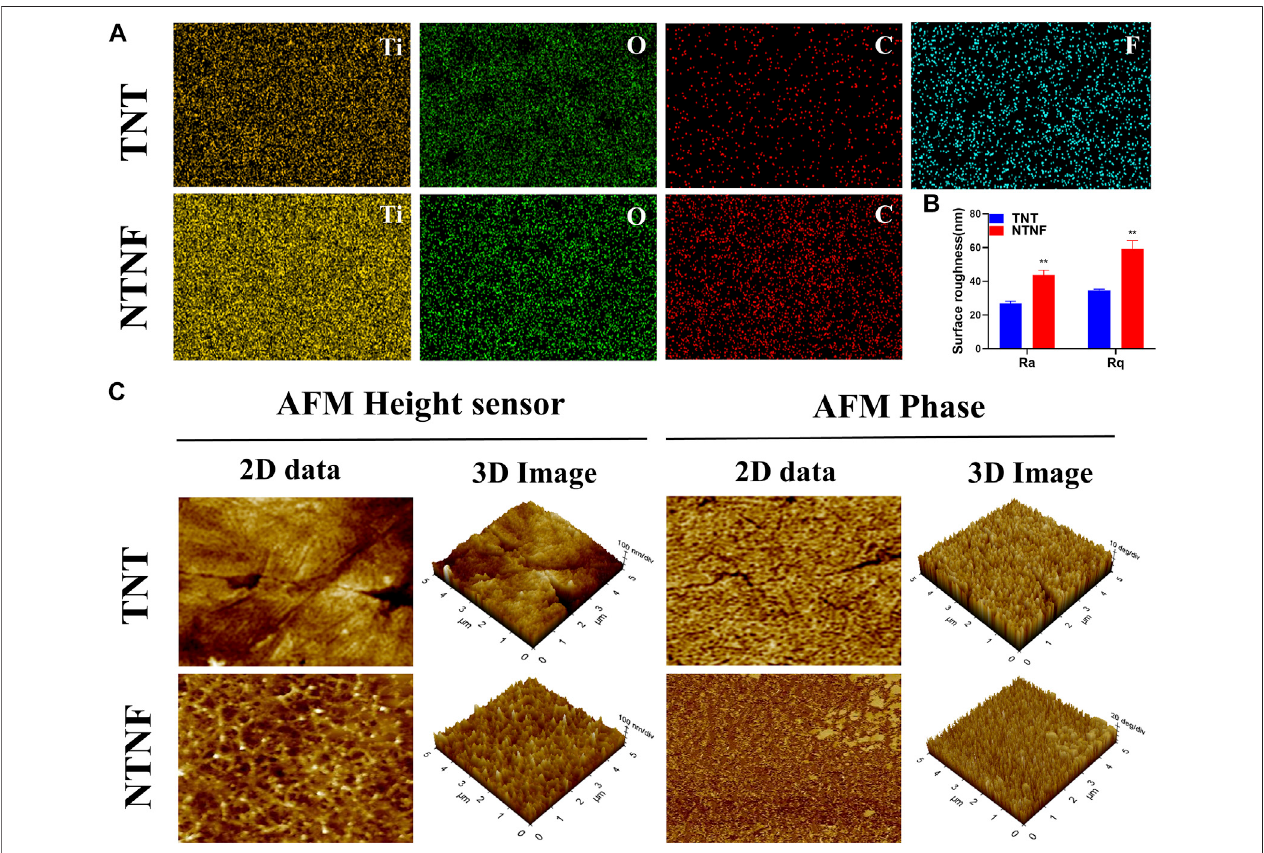
FIGURE 5 | (A) EDS mapping images of the TNT and NTNF. (B) Surface roughness measured by AFM. Ra, arithmetic average roughness; Rq, root-mean-square roughness. ** p < 0.01 compared with the TNT group. (C) 2D and 3D AFM images of height sensor, phase, and amplitude on the surface of the TNT and NTNF.